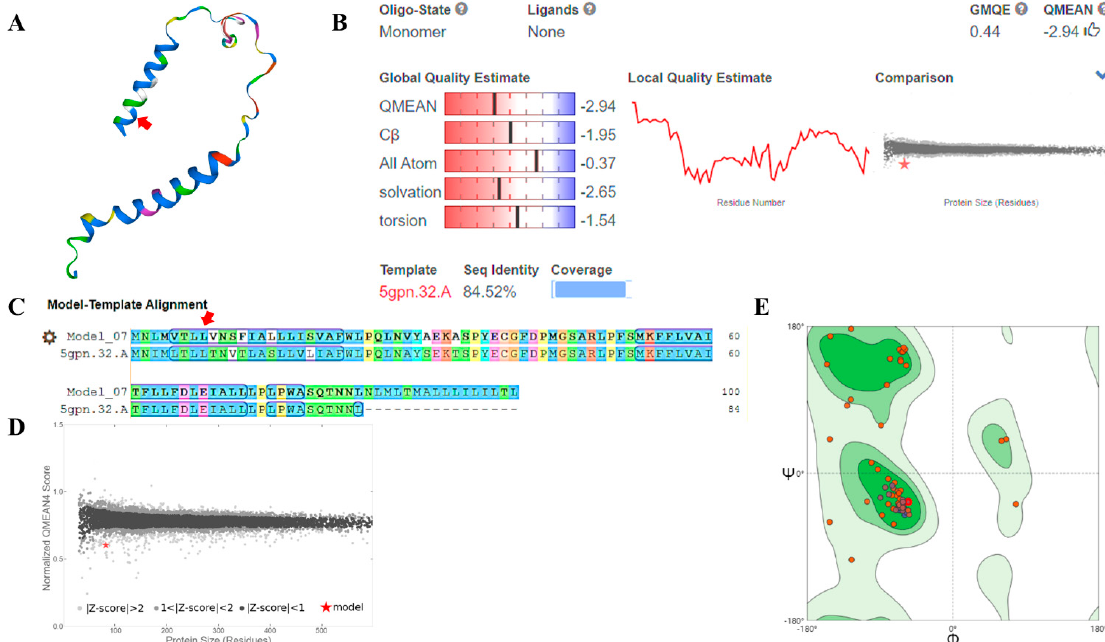
Figure 6. Modelling results and evaluations of ND3 protein tertiary structure of Himalayan marmot. Using the Swiss-Model website, we obtained the ND3 protein tertiary structure for the Himalayan marmot ( A ). The accuracy of the target protein structure is evaluated using QMEAN, sequence identity ( B ), target-template sequence alignment ( C ), Z-score ( D ), and Ramachandran plots ( E ). ψ and ϕ are dihedral angle of acid residues. The eighth amino acid in the sequence is marked with a red arrow, and the red star means the location of 5gqpn.32.A (model) in Z-score.